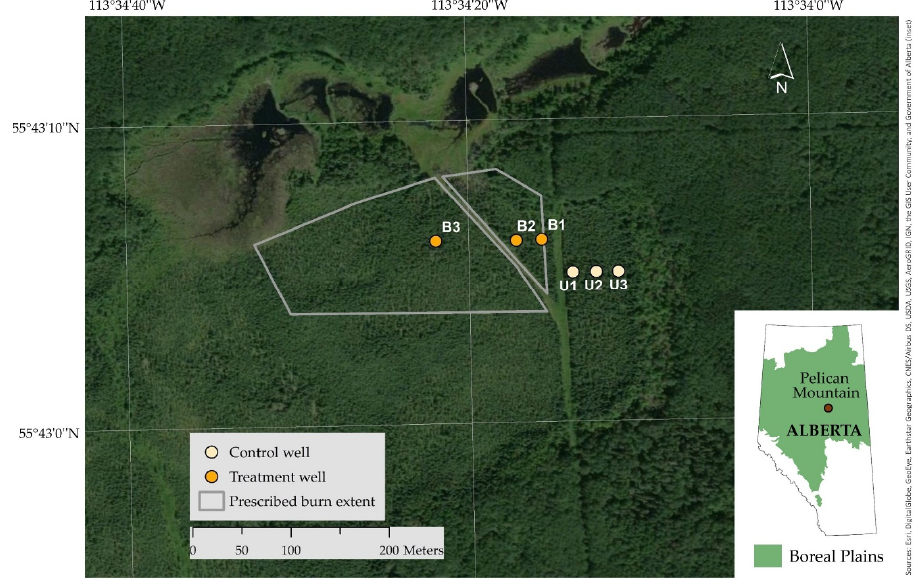
Figure 1. Location of the experimental block and monitoring wells (55°43′ N 113°34′ W) at the Pelican Mountain research site in northern Alberta, Canada, within the Boreal Plains ecozone. Monitoring wells were installed within the unburned (control) and burned (treatment) sections of the experimental block. Wells B1, B2, B3 were within the section burned in May 2019.